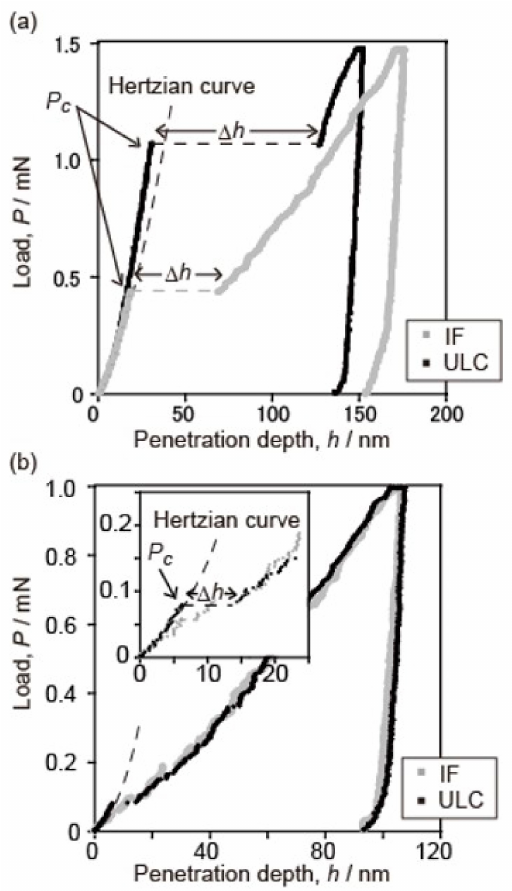
Figure 10. Typical load–displacement curves for ( a ) the low-density and ( b ) the high-density sam- ples